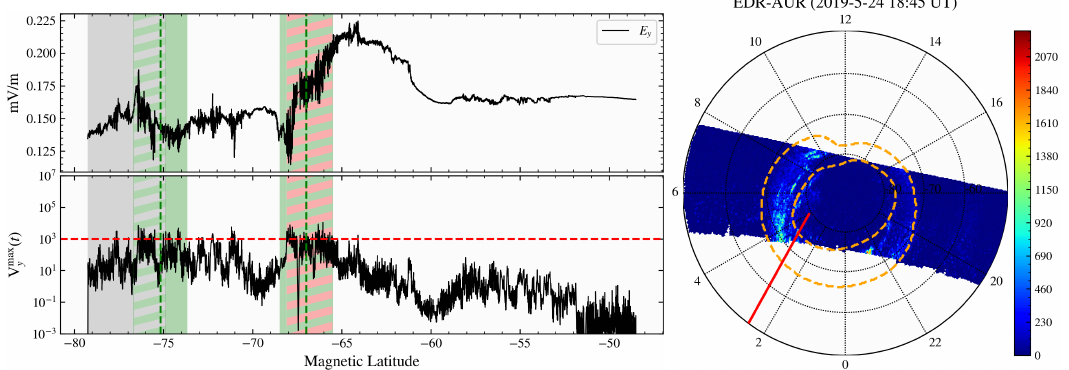
Figure 7. Same as Figure 5 ( left ) and the right panel of Figure 1 ( right ) except for orbit 7243. Positive detection, nightside southern